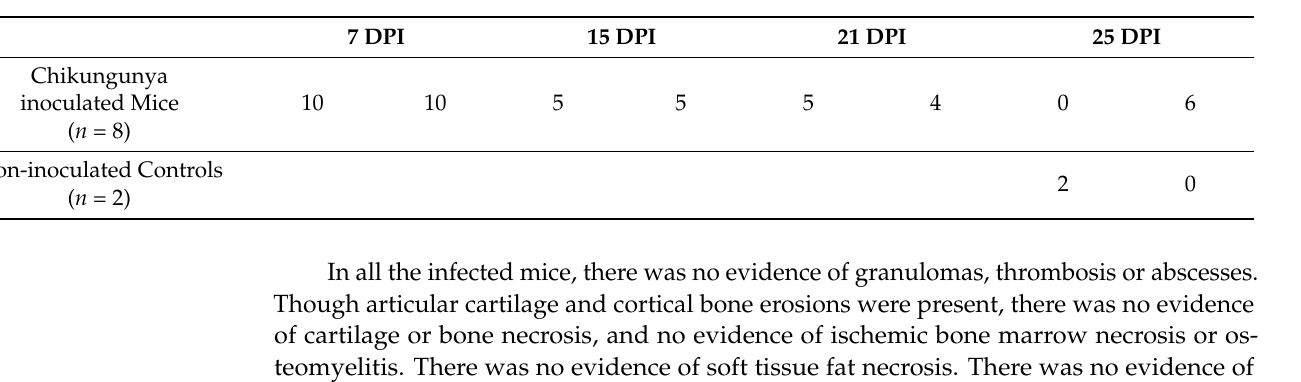
Table 1. Histologic inflammation score of ipsilateral lower extremity by days post infection (DPI) per mouse. The evaluation consisted of microscopic evaluation of inflammatory reaction and injury of the (1) synovium, (2) articular cartilage, (3) skeletal muscle and soft tissue, (4) periosteum, and (5) cortical bone. The scoring for each component ranged from zero to two, with zero indicating no injury or inflammation, two represents significant injury and inflammation, and one representing intermediate involvement with respect to inflammation or injury for a total range in score of 0–10 per mouse, wherein 10 is the worst